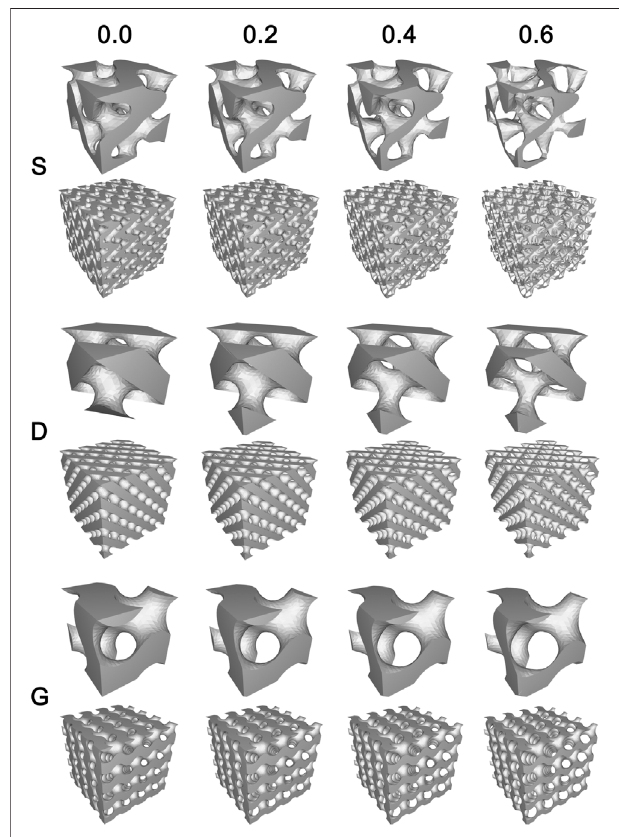
FIGURE 3 | The fi nal design diagram (stl. models) of twelve samples (three architectures combined four constants). The gradient variation of porous structures was clearly